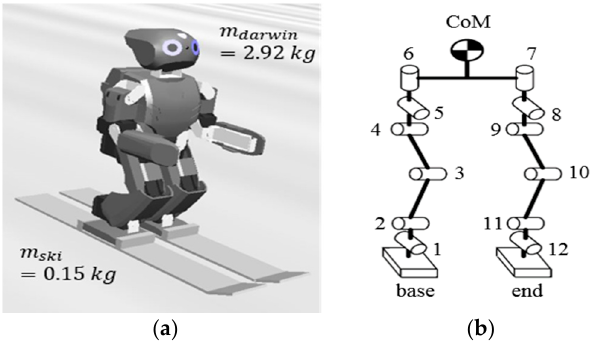
Figure 1. ( a ) DARwIn-OP robot and ski; ( b ) Kinematic lower body configuration of DARwIn-OP.